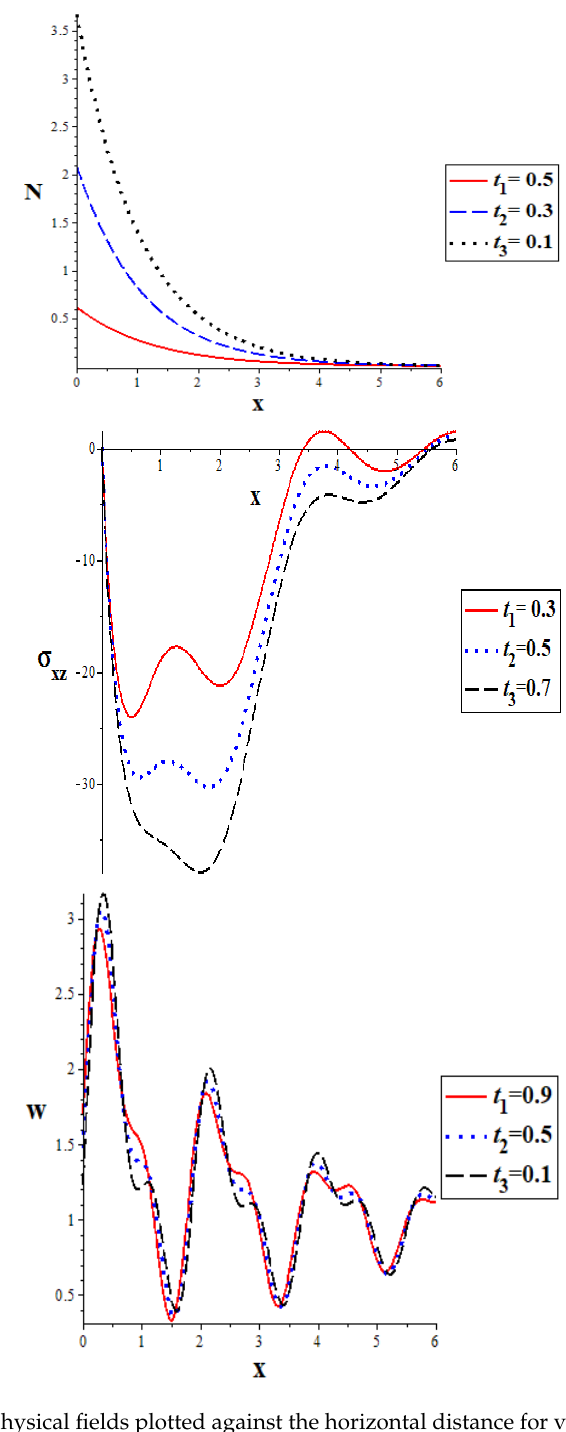
Figure 1. The main changes in the physical fields plotted against the horizontal distance for various short times in a rotational field and under initial hydrostatic stress